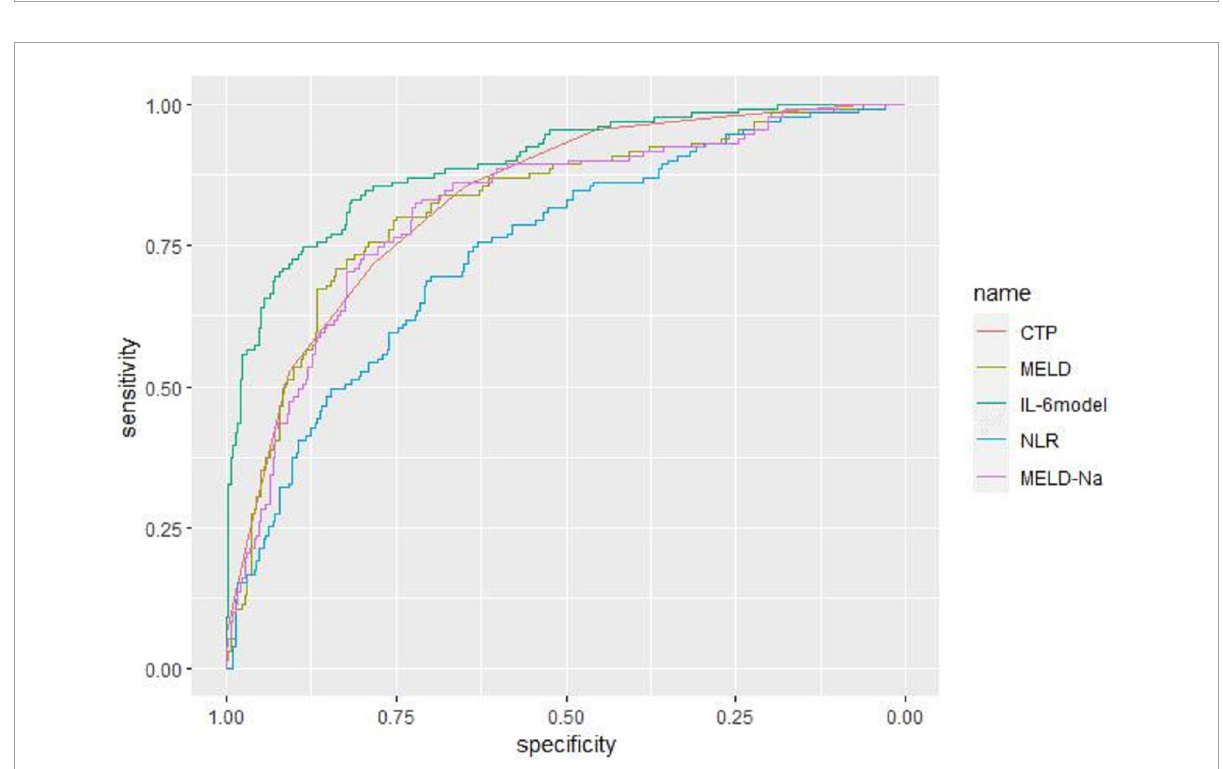
FIGURE7 The ROC curves and comparisons of prognostic scores for